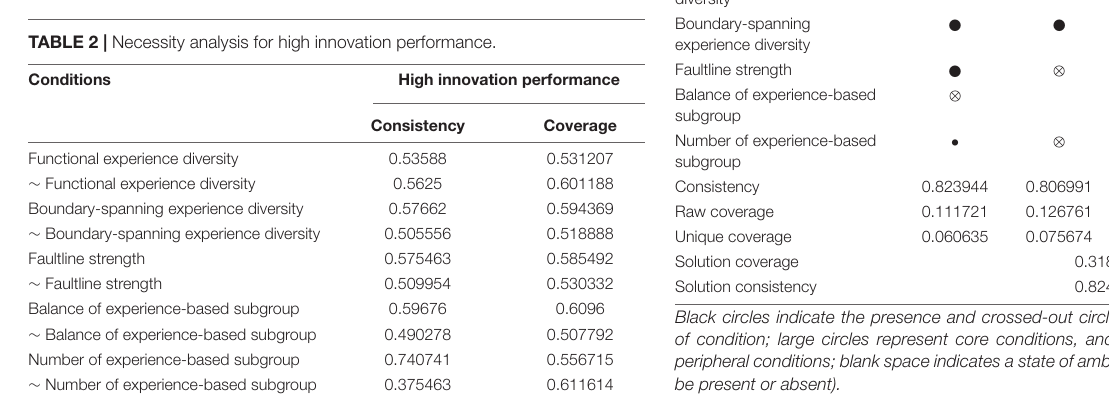
Black circles indicate the presence and crossed-out circles indicate the absence of condition; large circles represent core conditions, and small circles stand for peripheral conditions; blank space indicates a state of ambiguity (the condition may be present or